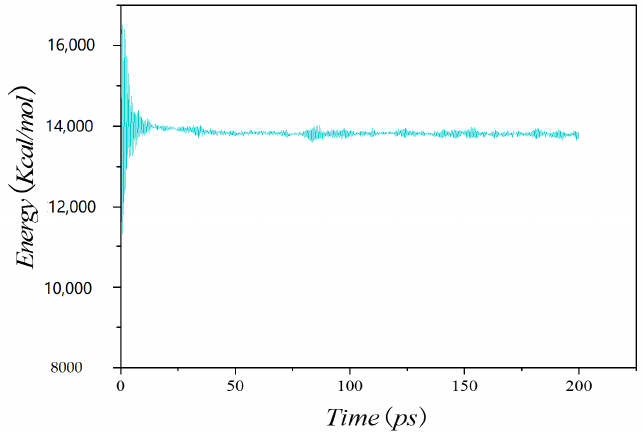
Figure 6. Energy change of relaxation process of mixed system.